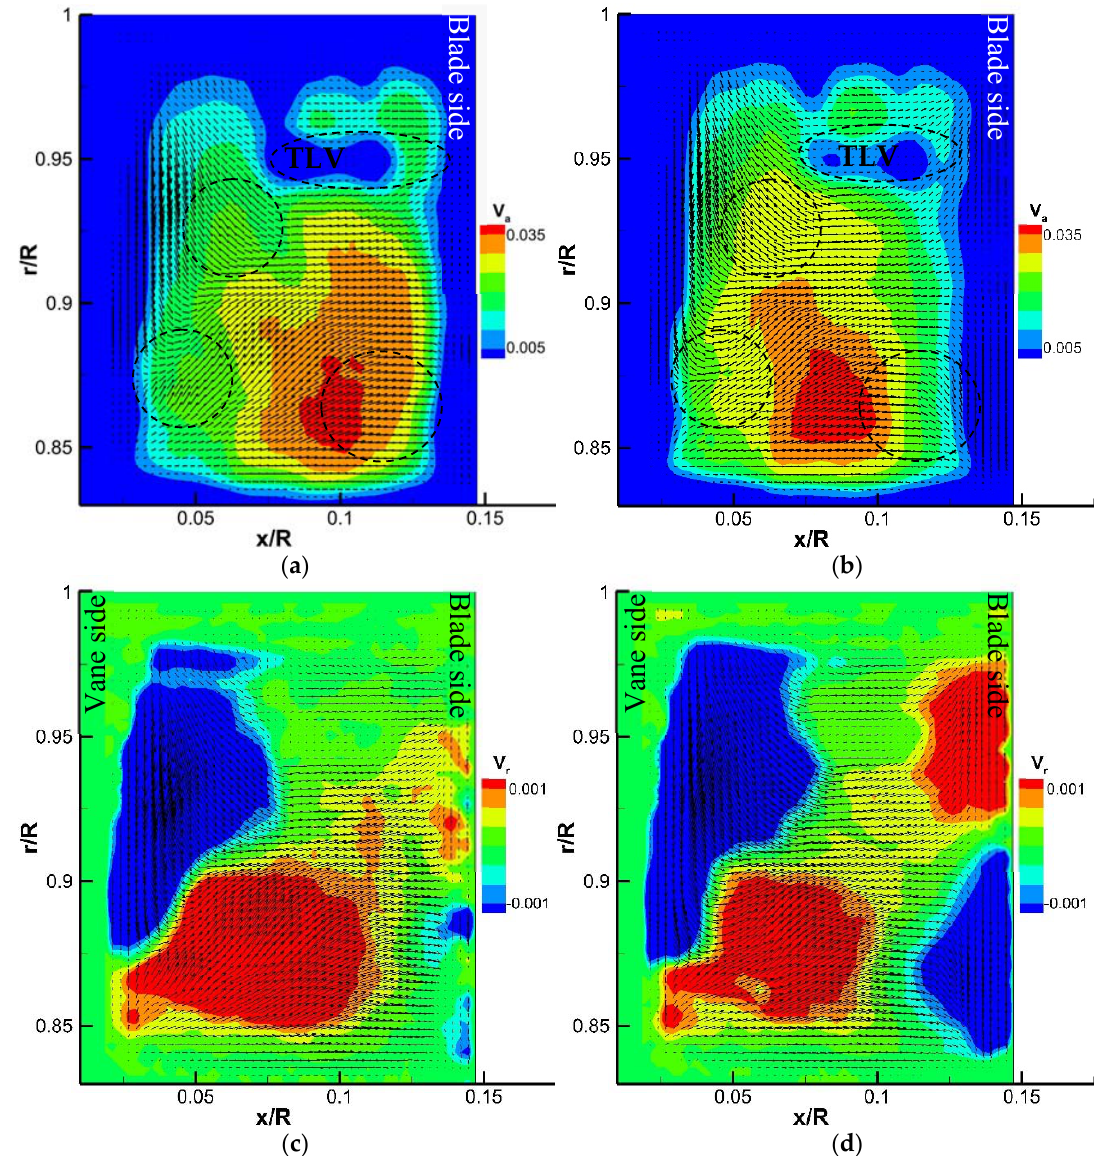
Figure 12. First order POD mode of MP7 at rotor position B & D. ( a ) V a contour plot, Position B; ( b ) V a contour plot, Position D; ( c ) V r contour plot, Position B; ( d ) V r contour plot, Position D.